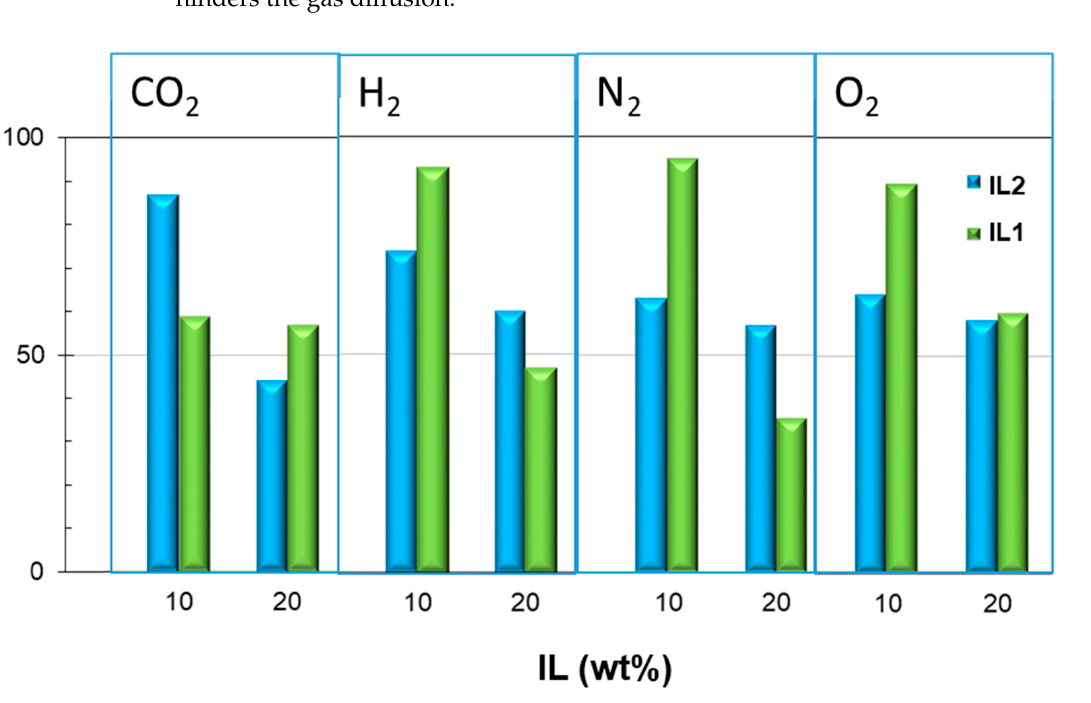
Figure 9. Gas diffusion coefficient in as-prepared Pebax ® Rnew composite membranes relative to neat Pebax ® ( D/D 0 ). T = 25 °C.